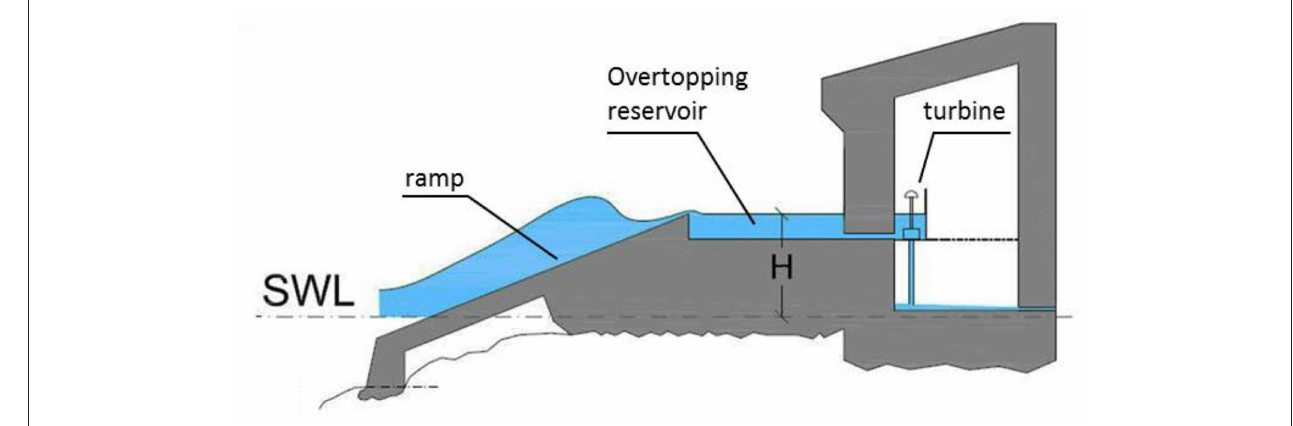
FIGURE 1 | OBREC illustration (Source: Iuppa et al., 2016).